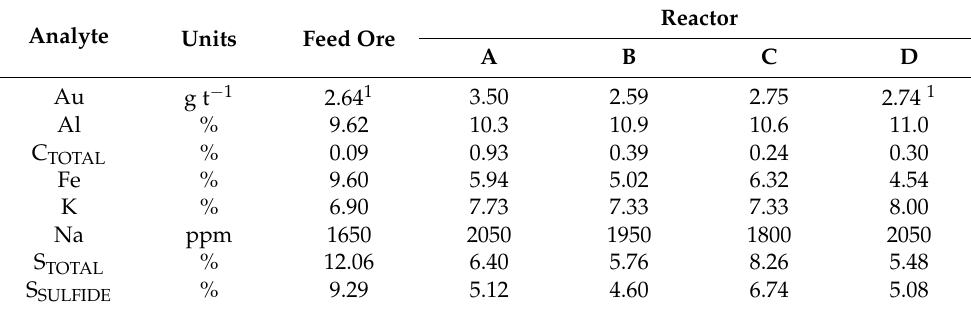
Table 5. Composition of feed ore and residues from pyrite oxidation experiment. Analyte Units Feed